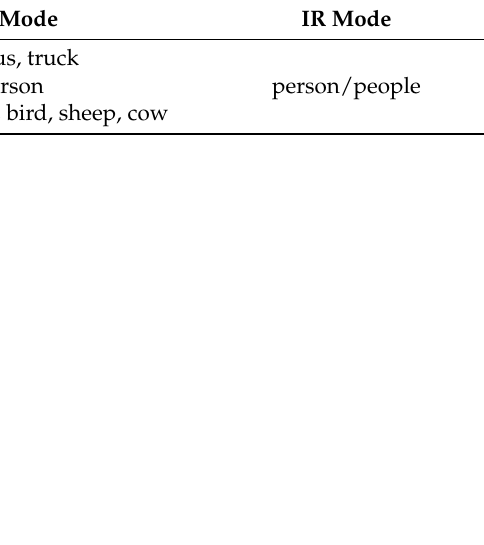
Table 4. Moving objects retrained in the novel system.